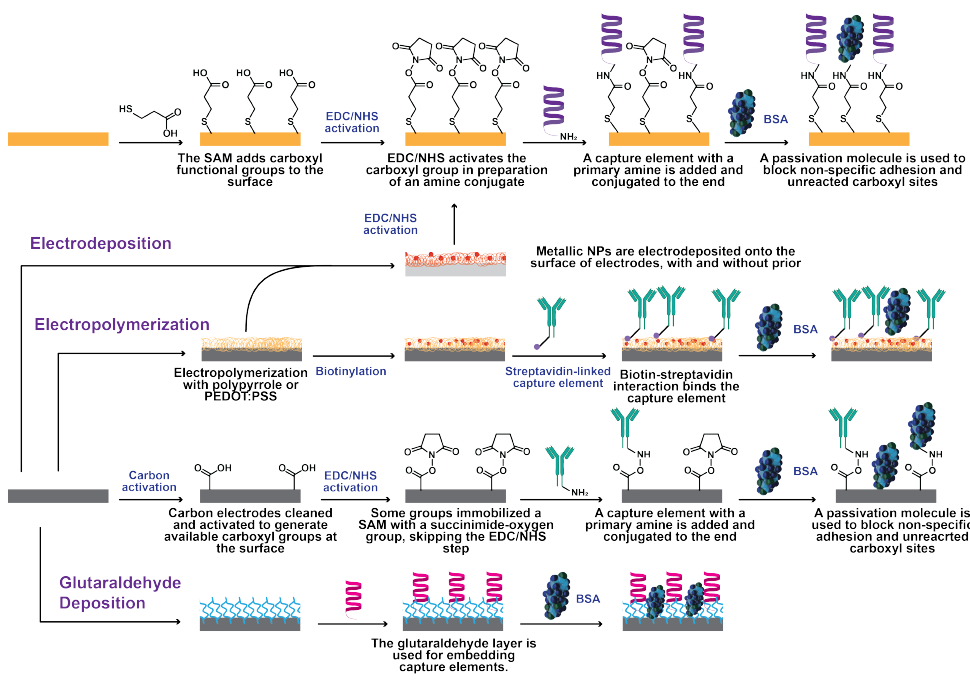
Figure 7. The fabrication schemes of different electrodes. Nearly all electrodes begin with a Au or carbon base, but have different modification steps. Au is most often used in conjunction with a thiol group to take advantage of thiol–Au chemistry, either with a thiol-based crosslinker (as shown here) or directly with a thiol-based capture element (such as an aptamer). Electropolymerization is used to add metal nanoparticles onto the surface of the electrodes. EDC/NHS steps can be applied either directly to a monolayer formed on Au or onto functional groups present in carbon electrodes. Glutaraldehyde is used for embedding capture elements in a matrix nonspecifically. BSA is used to block the electrode surface and prevent nonspecific